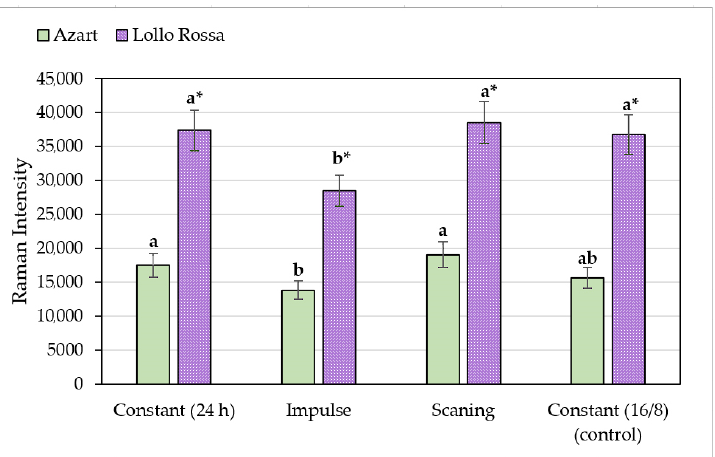
Figure 7. Varieties and variations in average intensity of significant peaks of the ‘Azart’ variety and ‘Lola Rossa’ on the 35th day of cultivation. Values represent mean SEM (n = 5). Letters indicate significant differences among treatment and control samples of ‘Azart’ variety, letters with asterisk sign –of ‘Lollo Rossa’ variety ( p < 0.05).